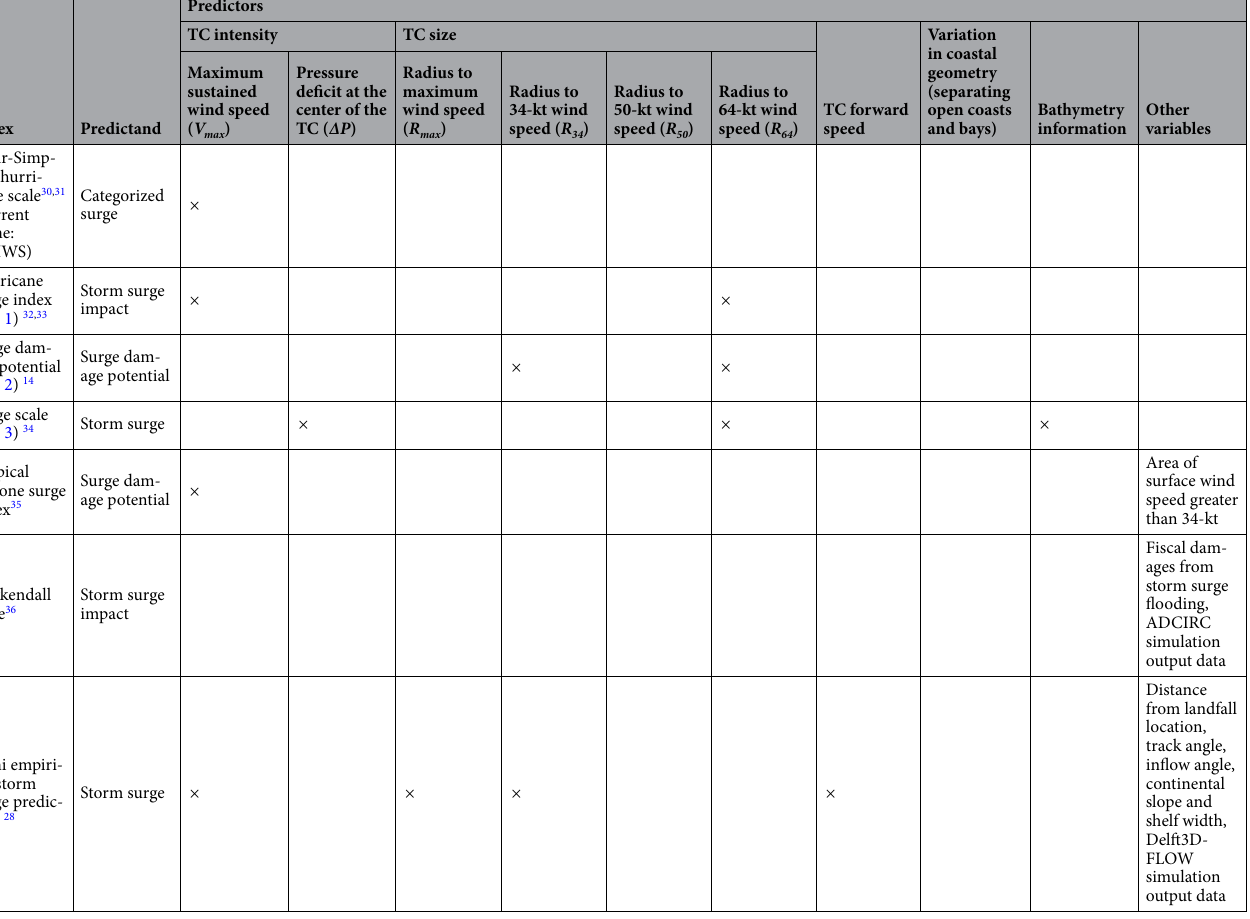
Table 1. A comparison of the characteristics of existing storm surge